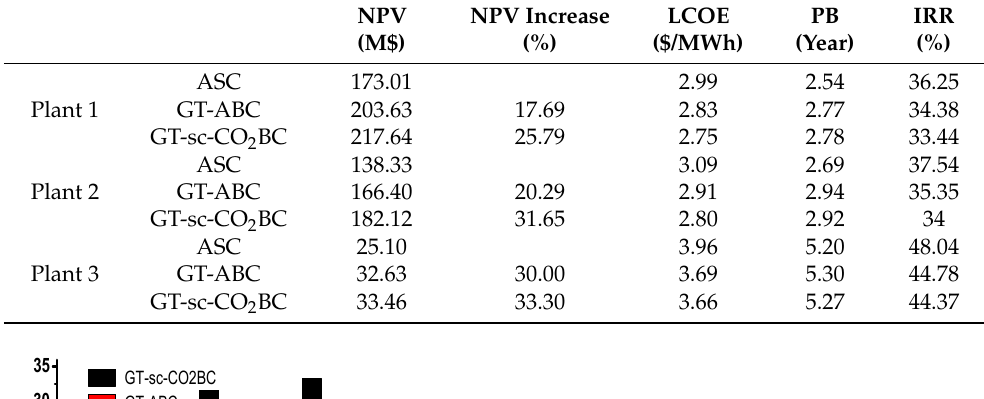
Table 16. ASC, GT-ABC, and GT-sc-CO 2 BC net present value for the three plants.